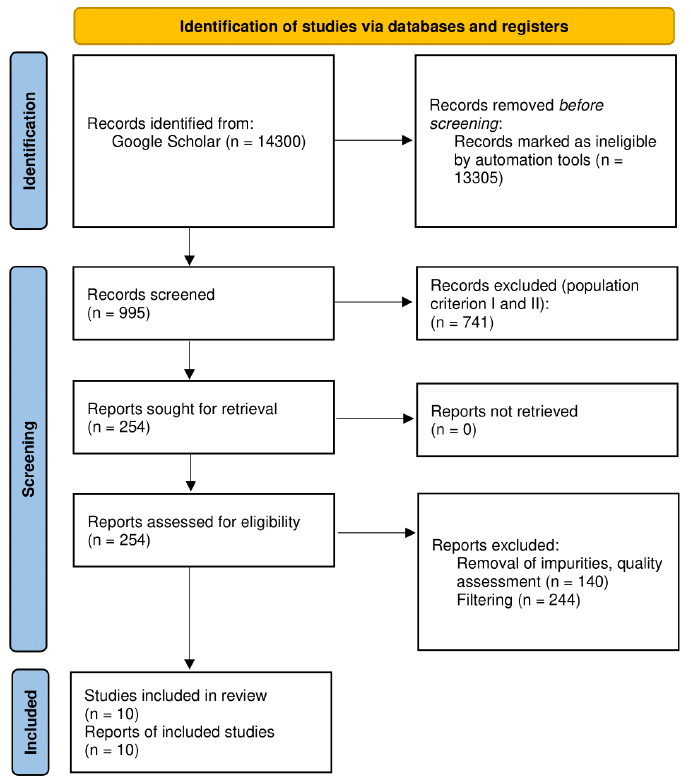
Figure 1. PRISMA diagram of the paper selection